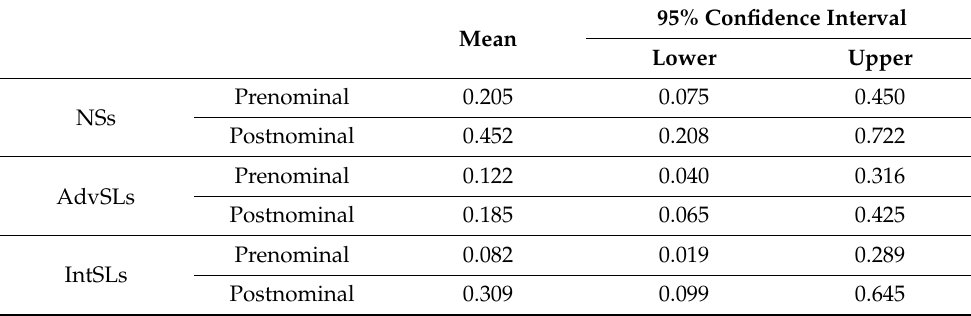
Table 5. Model estimates (probability of accuracy).